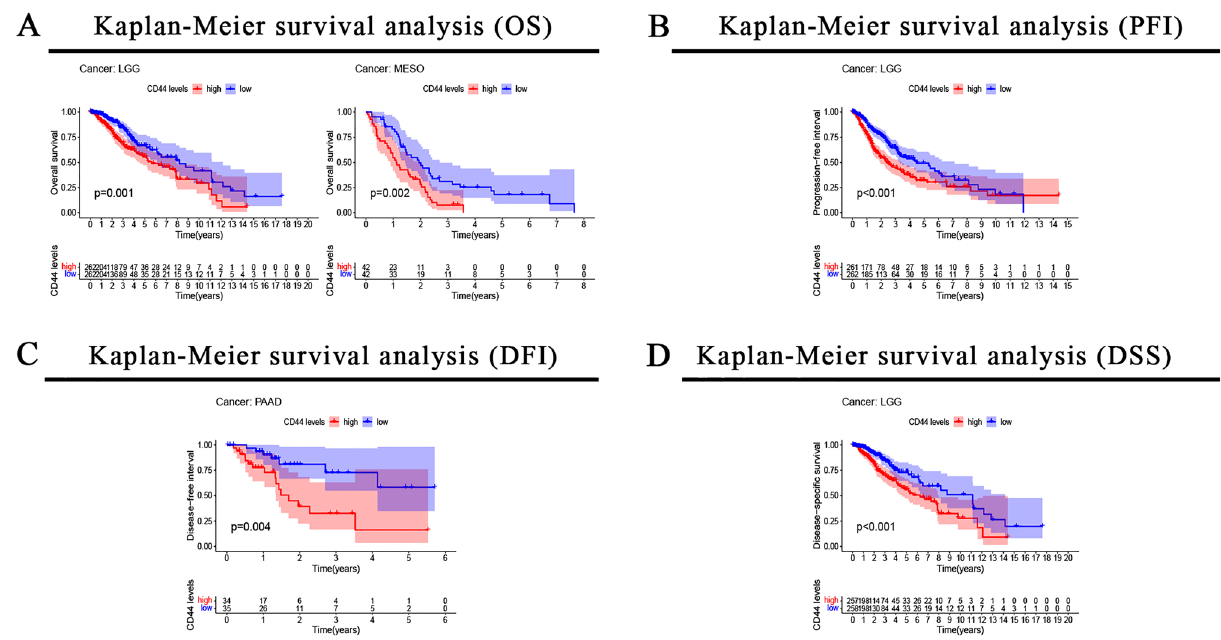
Figure 2. Correlation between CD44 expression level and OS ( A ), PFI ( B ), DFI ( C ), and DSS ( D ) as determined by Kaplan–Meier curve analyses. OS overall survival, PFI progression-free interval, DFI disease-free interval, DSS disease-specific Figure S1A online). Cox regression analysis of DSS demonstrated that CD44 expression as a risk factor in KIRC ( P < 0.001), LGG ( P < 0.001), PAAD ( P = 0.004), while it was a protective factor in BRCA ( P < 0.001), UVM ( P = 0.002) (see Supplementary Fig. S1B online). Cox regression analysis of DFI noted that CD44 expression was a risk factor in PAAD ( P = 0.001) (see Supplementary Fig. S1C online). Cox regression analysis of PFI identified that CD44 acted as a detrimental prognostic factor in KIRC ( P < 0.001), LGG ( P < 0.001), PAAD ( P < 0.001) (see Supplementary Fig. S1D online) (Table 2). Altogether, these results signal that CD44 may serve as a prognostic biomarker and potential therapeutic target.